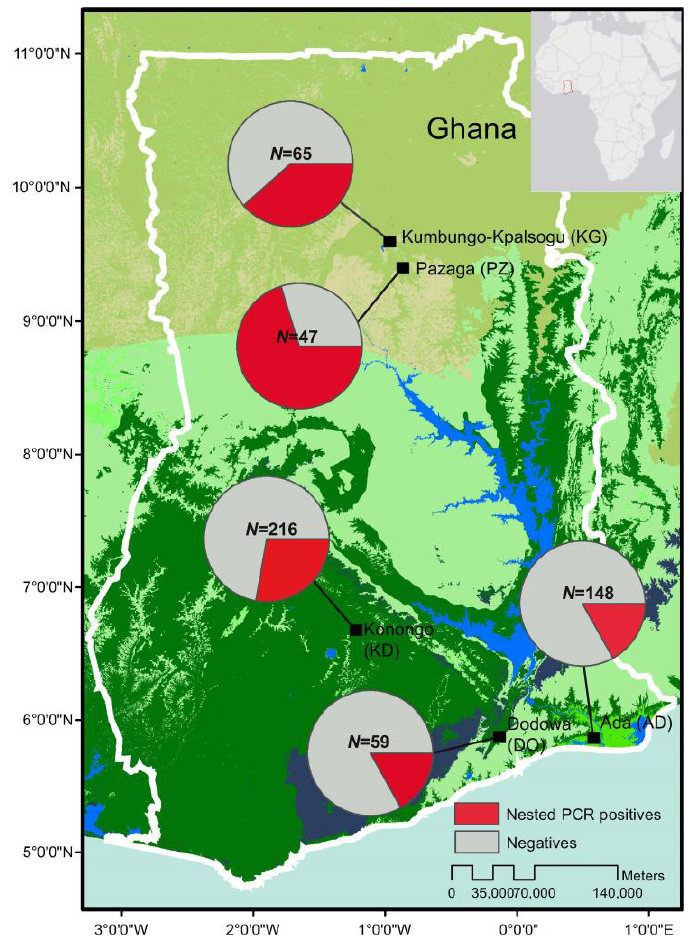
Figure 1. Map showing the study sites in Ghana and the prevalence of asymptomatic P. falciparum infections based on 18S rRNA nested PCR (pie charts). N indicated the total number of samples collected and screened in each of the study sites (Supplementary Table S2).